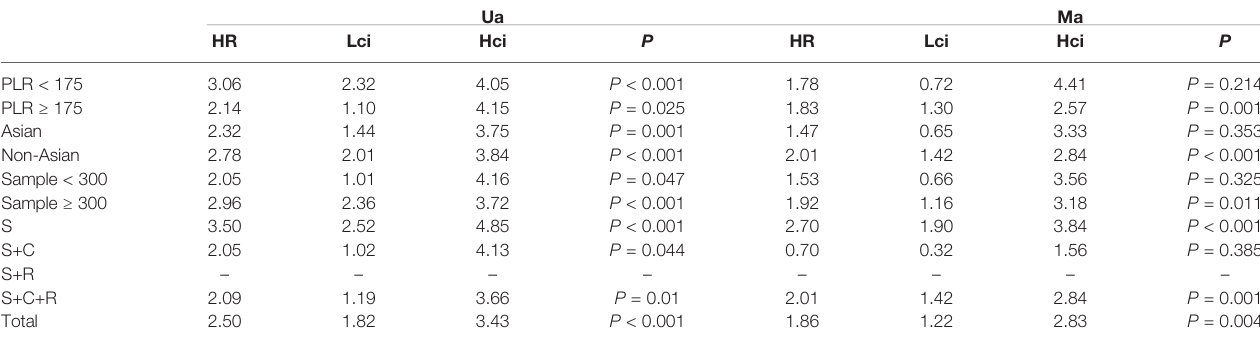
TABLE 5 | The results of the subgroup analysis for platelet – lymphocyte ratio and overall survival are summarized below.